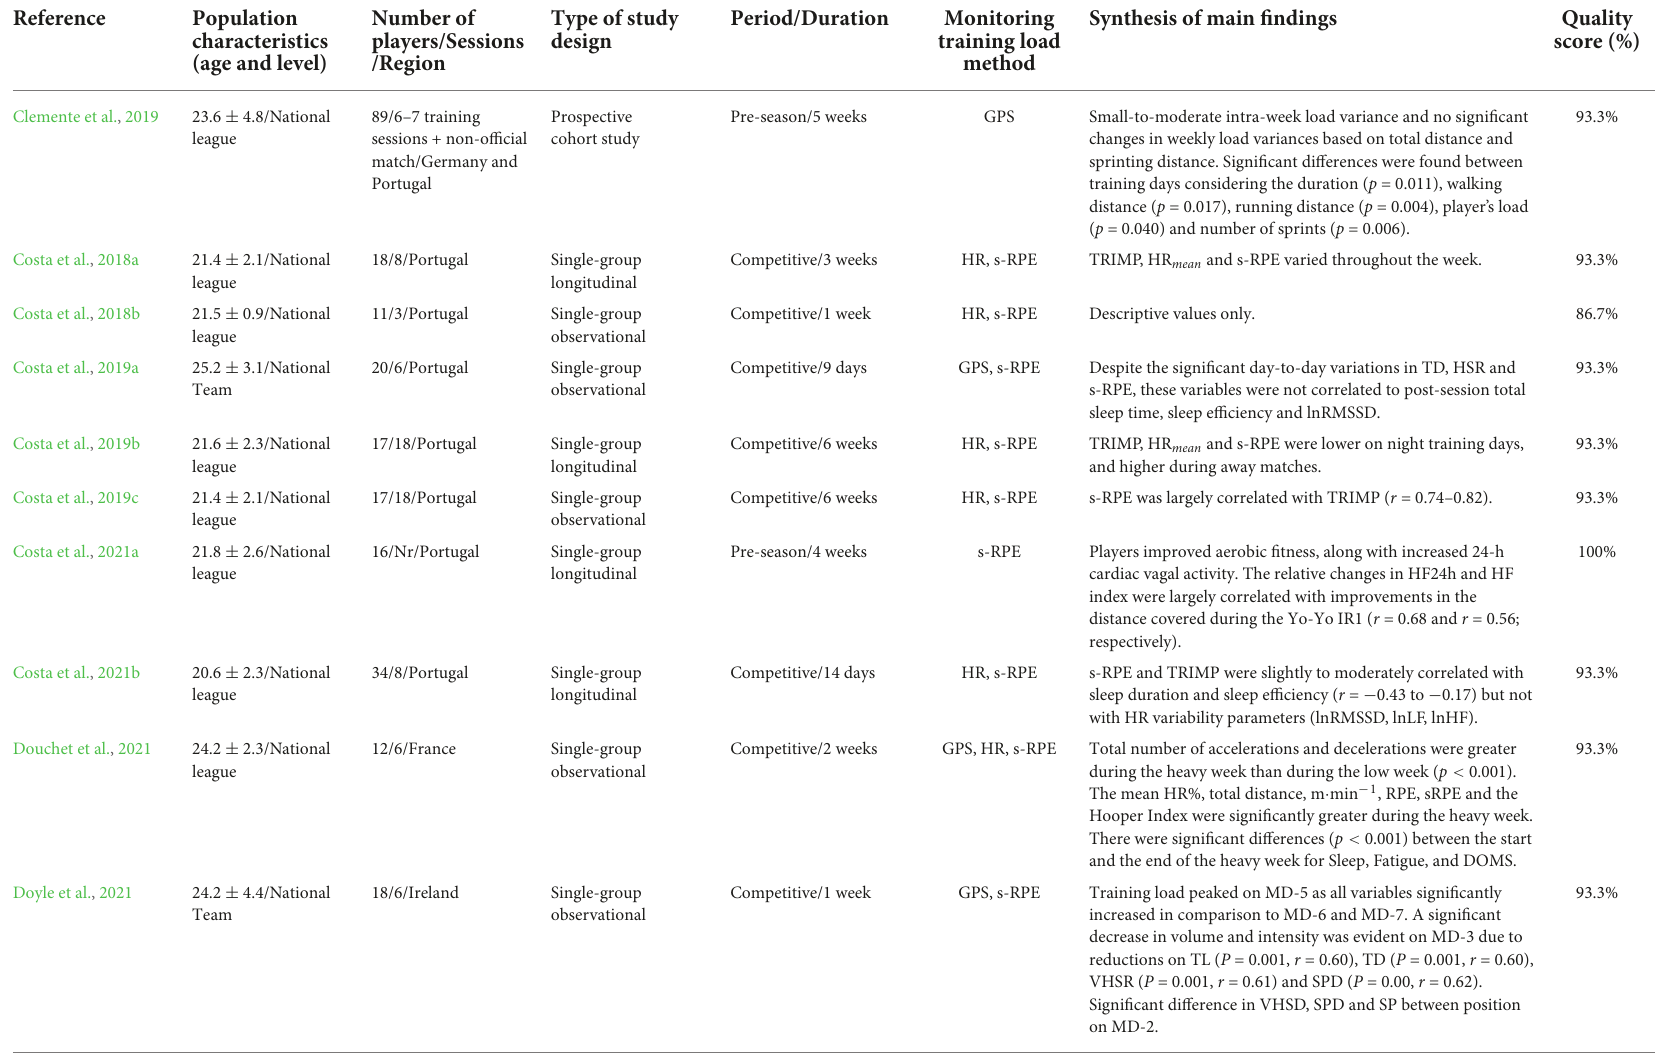
TABLE 1 Studies quantifying training load in highly trained and elite adult women’s soccer players over a minimum of 1 week ( n = 16), and respective quality